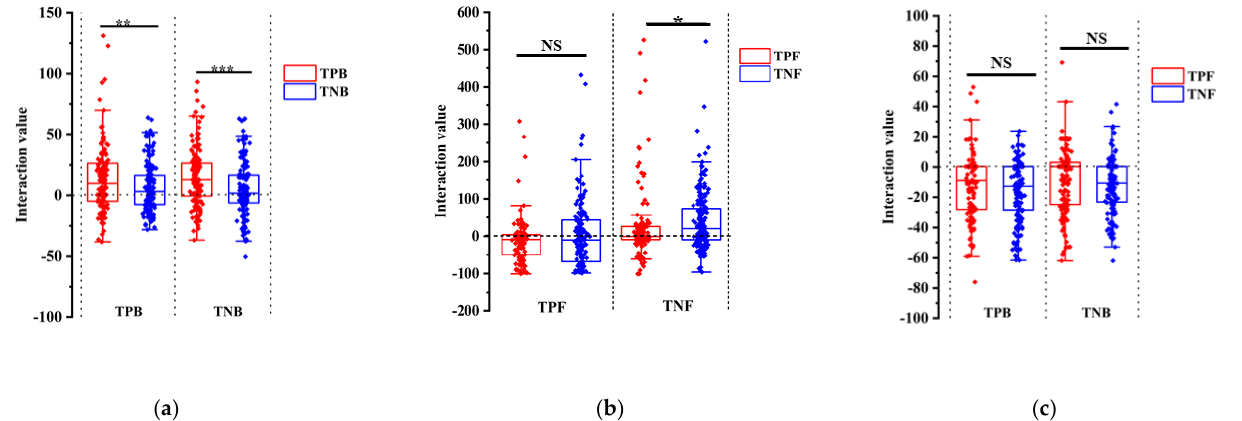
Figure 5. Correlation analysis between growth regulation effect of triterpenoids and the interaction. ( a ) Correlation analysis between growth regulation effect of triterpenoids on endophytic bacteria and the interaction of endophytic bacteria. ( b ) Correlation analysis between growth regulation effect of triterpenoids on endophytic fungi and the interaction of endophytic fungi. ( c ) Correlation analysis between growth regulation effect of triterpenoids on endophytes and the interaction between endophytes. Asterisks indicate significant differences between the group: *** p < 0.001, ** p < 0.01, * p < 0.05, nonparametric test, Wilcoxon signed rank test. Three biological replicates per treatment were used for analysis. Error bars represent the SEM.